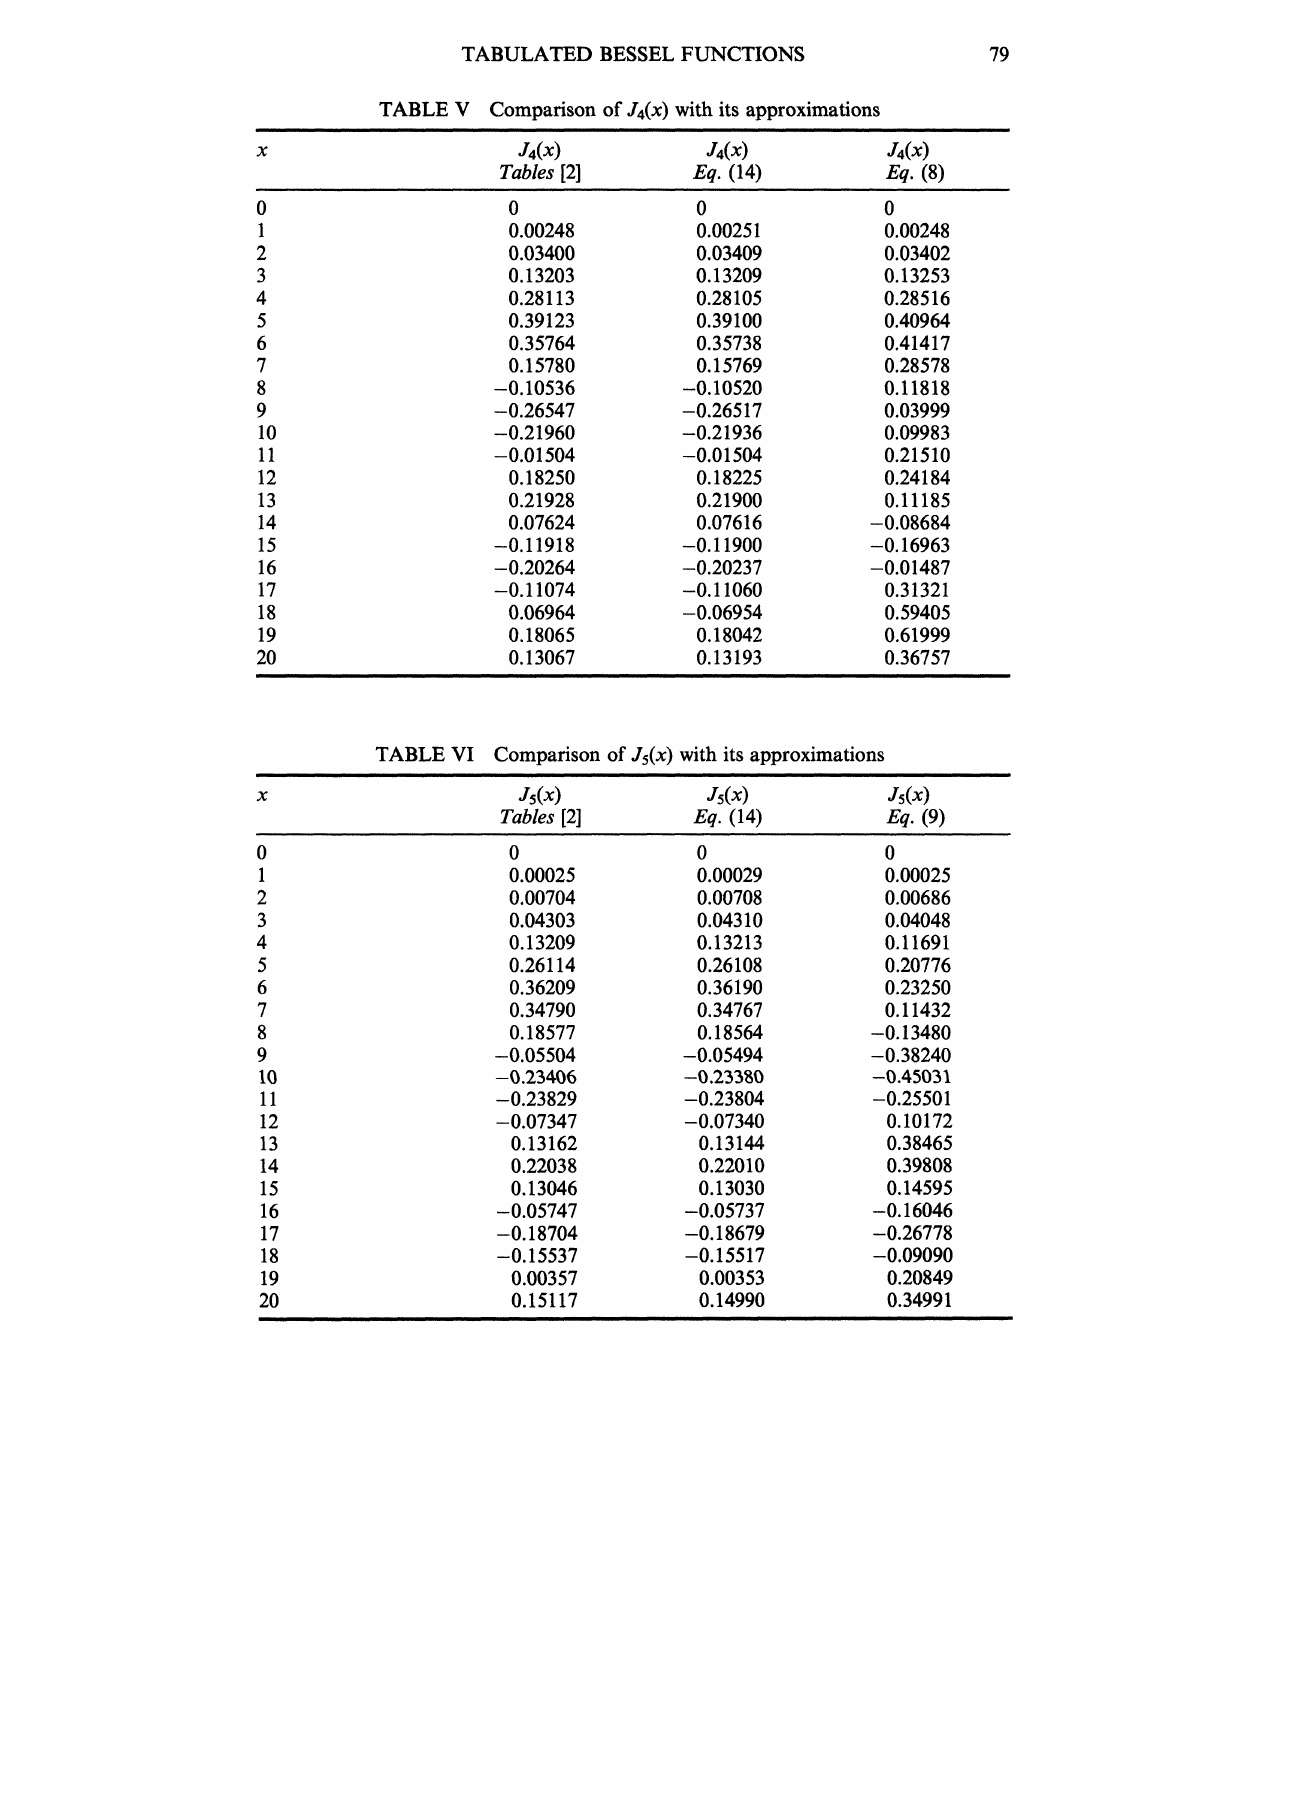
TABLE VI Comparison of Js(x) with its